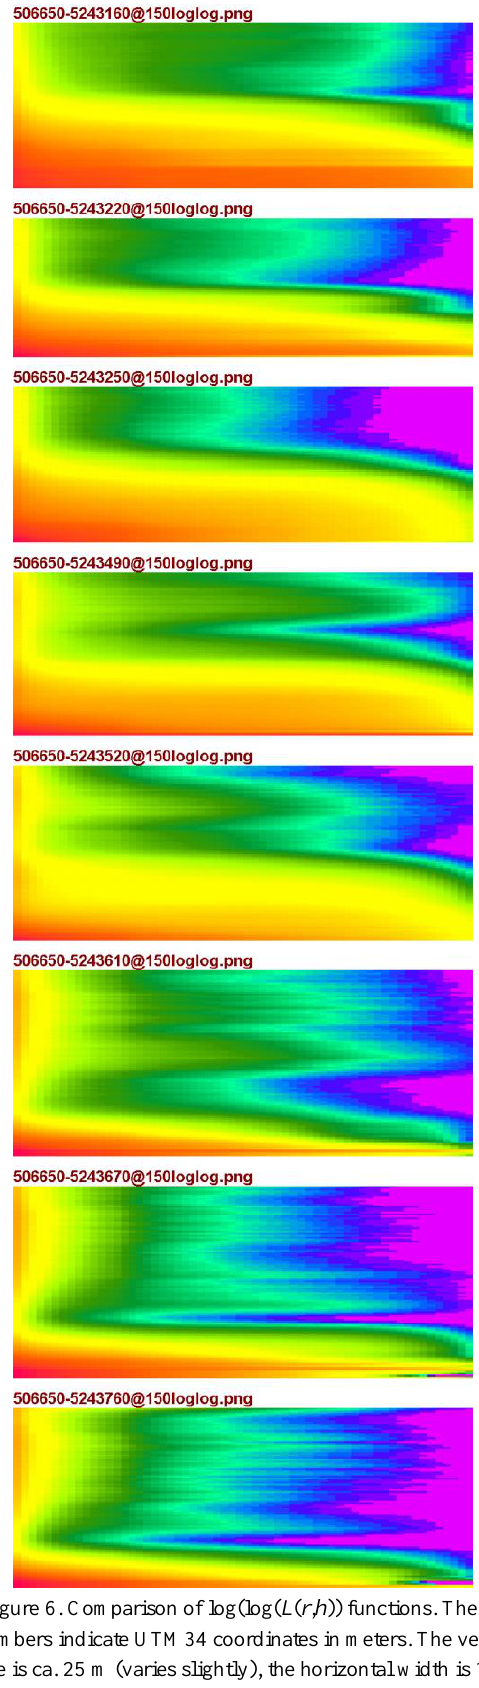
Figure 6. Comparison of log(log( L ( r , h )) functions. The first numbers indicate UTM34 coordinates in meters. The vertical scale is ca. 25 m (varies slightly), the horizontal width is 100